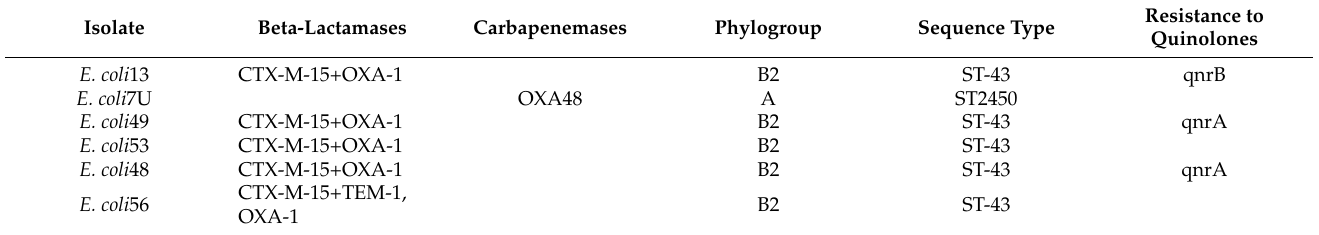
Table 2. Molecular characterization of Escherichia coli and Klebsiella pneumoniae isolates from outpa- tients with urinary